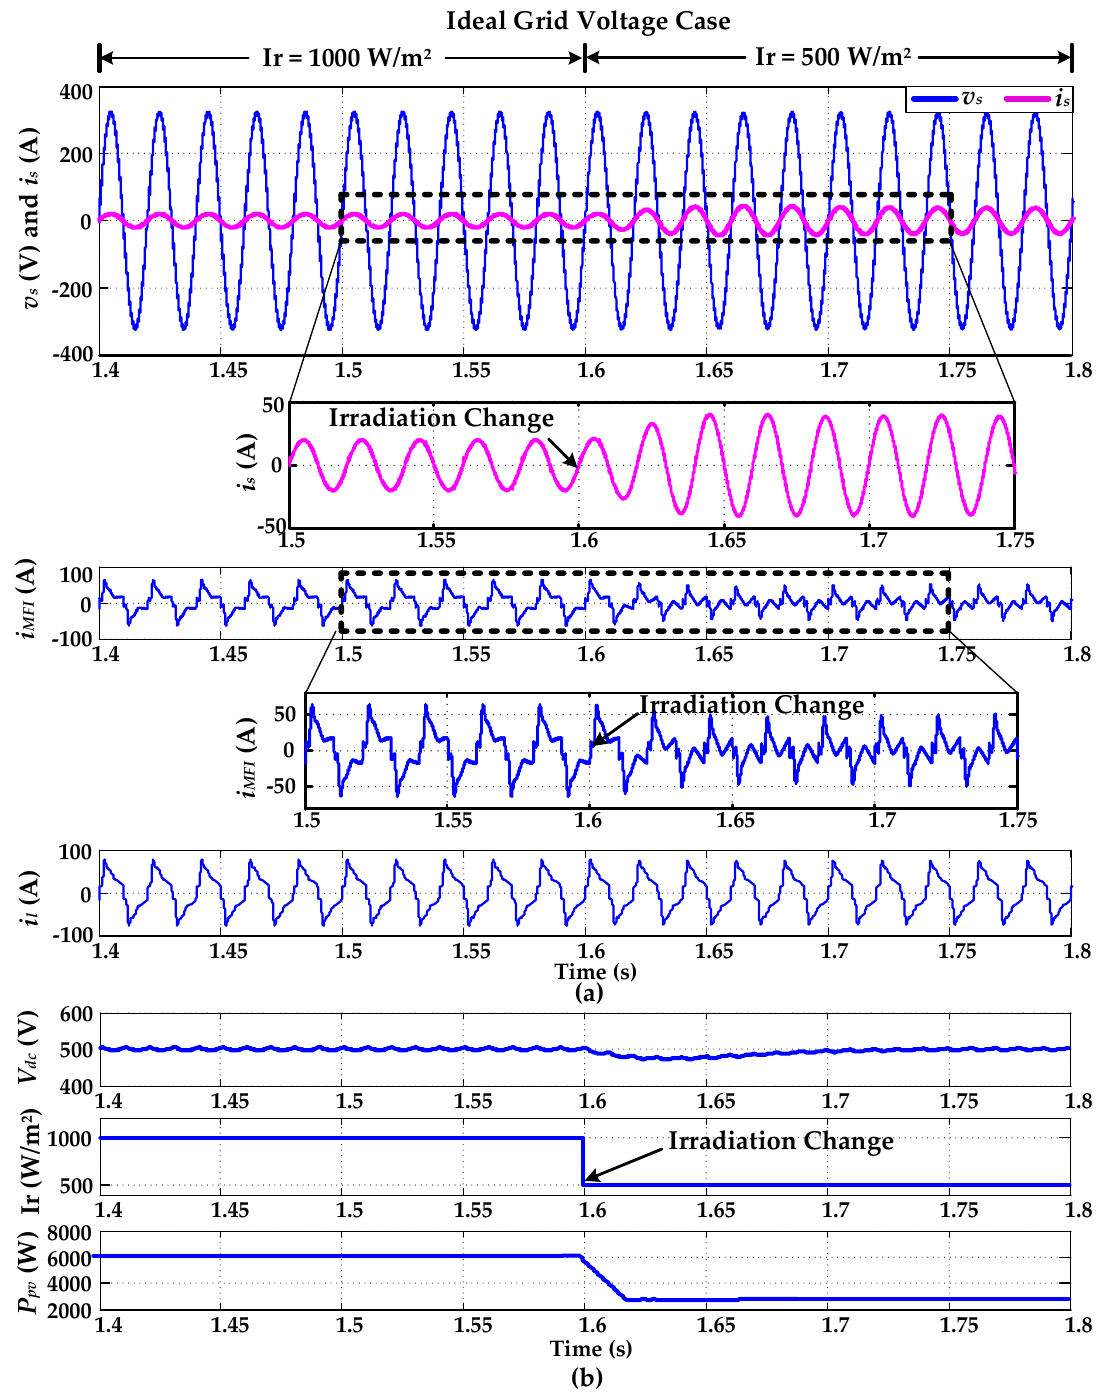
Figure 10. Dynamic response at PCC during grid sharing and power conditioning; ( a ) ideal grid input voltage, current, MFI current, and load current; ( b ) MFI DC-link voltage, solar irradiation, and PV power under the ideal grid.